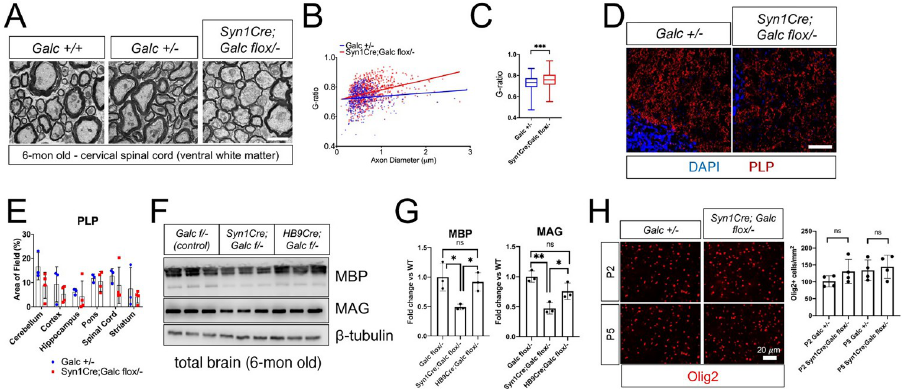
Fig 7. Myelin and myelin proteins are marginally reduced in the brain of Syn1Cre; Galc flox/− . Electron microscopy analysis of the cervical spinal cords ( A ) and their morphometry g-ratio quantifications ( B, C ) from 6-month-old Syn1Cre; Galc flox/− and controls ( Galc +/+ and + /− ). The myelin sheaths were significantly thinner in Syn1Cre; Galc flox/− versus controls; the mean g-ratio of Galc + /− was 0.72, whereas that of the mutant was 0.76. All data are presented as mean values ± SD. Welch t test was used; ��� P < 0.001. The box bounds in the box plots for the g- ratio are 25th and 75th percentiles, the center lines are median value, and the whiskers are 0.05 and 0.95 percentiles. ( D ) Immunohistochemistry on brain sections shows that a decrease in the level of myelin protein PLP in the brains of 6-month-old Syn1Cre; Galc flox/− , compared to control ( Galc + /− ). Scale bar = 100 μ m. ( E ) Quantification of PLP level, measured by averaged integrated signal intensity, reveals a trend of reduction in the mutant brain. ( F ) Western blot analysis revealed that myelin proteins such as MBP and MAG were reduced in the pan-neuron specific mutant Syn1Cre; Galc flox/− , but not in the MN mutant HB9Cre; Galc flox/− . ( G ) Quantification of the protein band density shows the dramatic reduction of MBP and MAG levels in the Syn1Cre; Galc flox/− , but not in HB9Cre; Galc flox/− , compared to control ( Galc + /− ). ( H ) Immunohistochemistry of Olig2-positive cells shows that there was no change in the number of OL lineage cells in the brainstem of Syn1Cre; Galc flox/− , compared to Galc +/− . N = 3. Data are presented as mean values ± SEM; � P < 0.05, �� P < 0.01, ��� P < 0.001, and ns, not significant. The underlying data for B , C , E , G , and H can be found in S1 Data. GALC, galactosylceramidase; MAG, and myelin-associated glycoprotein; MBP, myelin basic protein; MN, motor neuron; PLP, proteolipid protein.